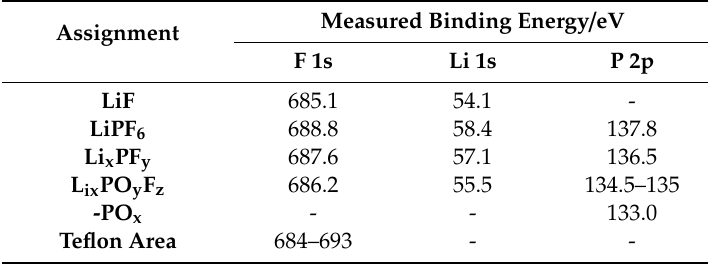
Table 4. Binding energies values for degradation